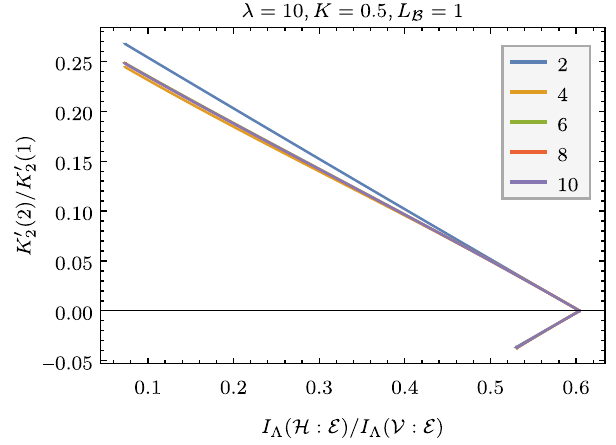
FIG. 12. The ratio between next-nearest-neighbor and nearest- neighbour coupling constants is plotted versus the mutual information for different orders of the cumulant expansion (see inset legend). The curves are obtained by parametrizing the RG rule by ð λ 1 ; λ 2 Þ ¼ λ ½ cos ð θ Þ ; sin ð θ Þ(cid:2) and varying θ ∈ ½ 0 ; π (cid:2)